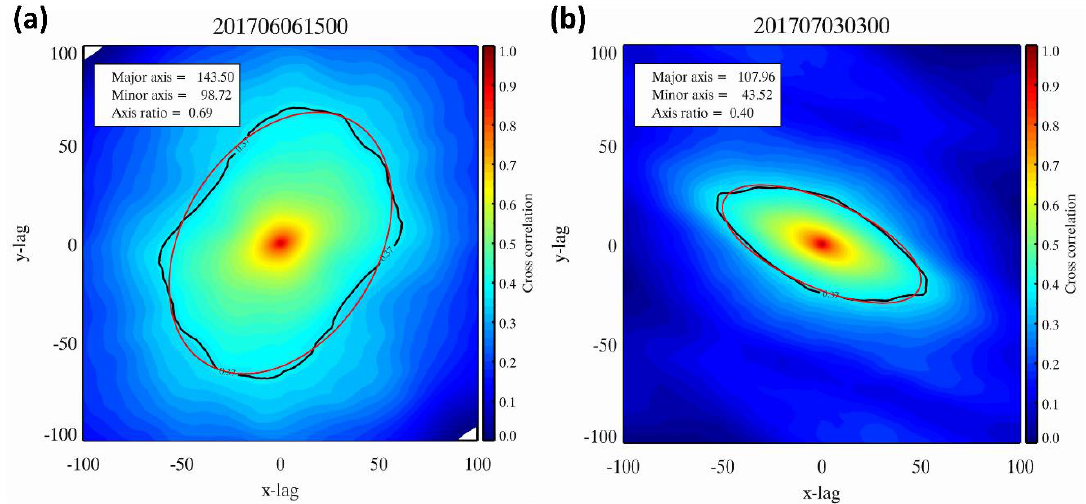
Figure 3. Spatial autocorrelation of two-dimensional rainfall rate of ( a ) the stratiform case (06/06/2017 1500 KST) and ( b ) the convective case (07/03/2017 0300 KST).